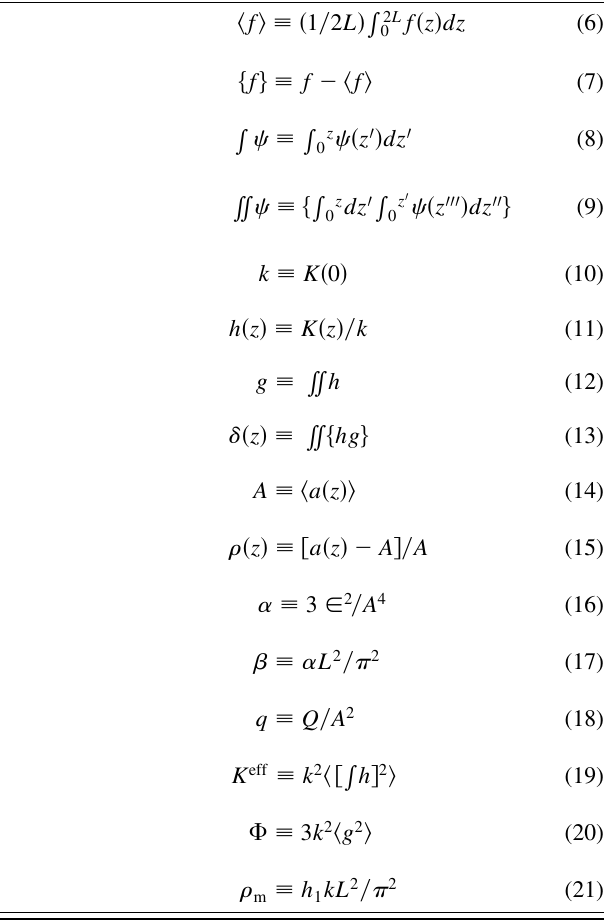
TABLE I. Collection of definitions to be used in this